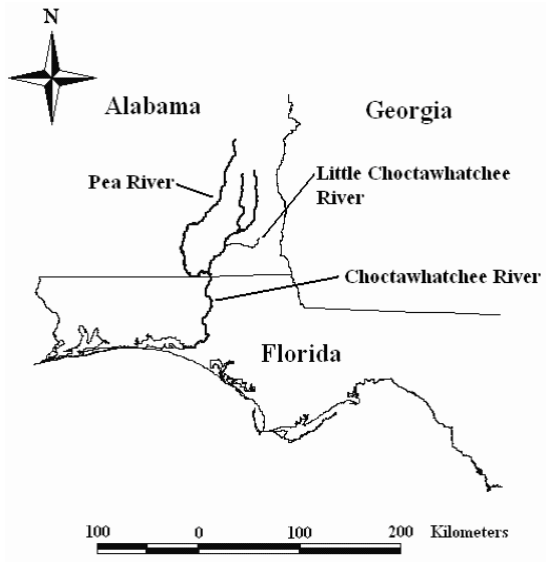
Figure 1. Little Choctawhatchee River near Dothan in southeast